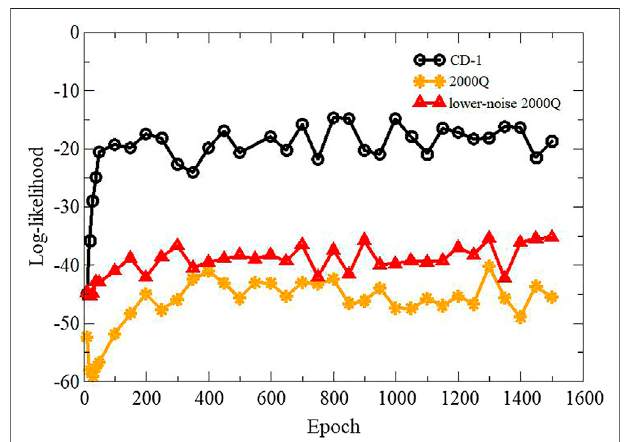
FIGURE 7 | Plot showing variation in log-likelihood with training epochs. Label CD-1 represents CD-based RBM training, while label 2000Q indicates QA-based RBM training employing the D-Wave 2000Q.